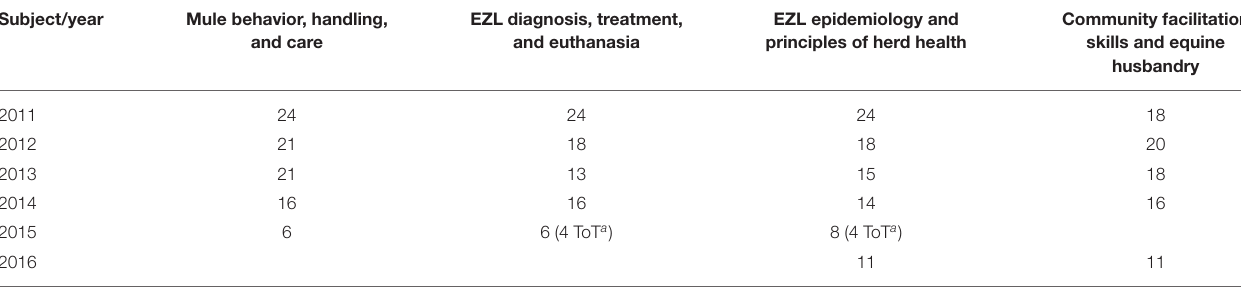
TABLE 7 | Trainings provided for animal healthcare professionals and number of